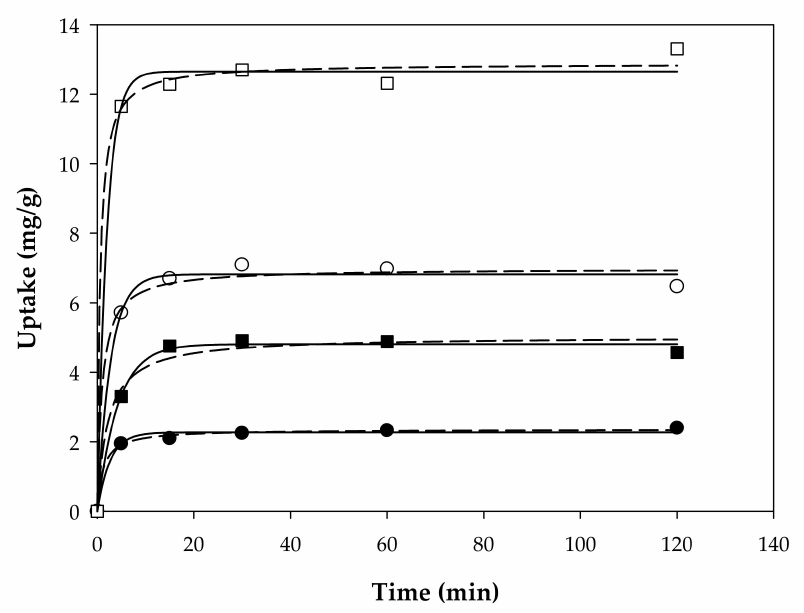
Figure 3. Representation of the adsorption kinetics for two concentrations of Basolite ® F-300 (circle: 65.8 mg/L and square: 263 mg/L), and it distinguishes the two concentrations of the pollutant between black (10 mg/L) and white (50 mg/L). Data represent the mean values for triplicate samples with a standard deviation below 5%.